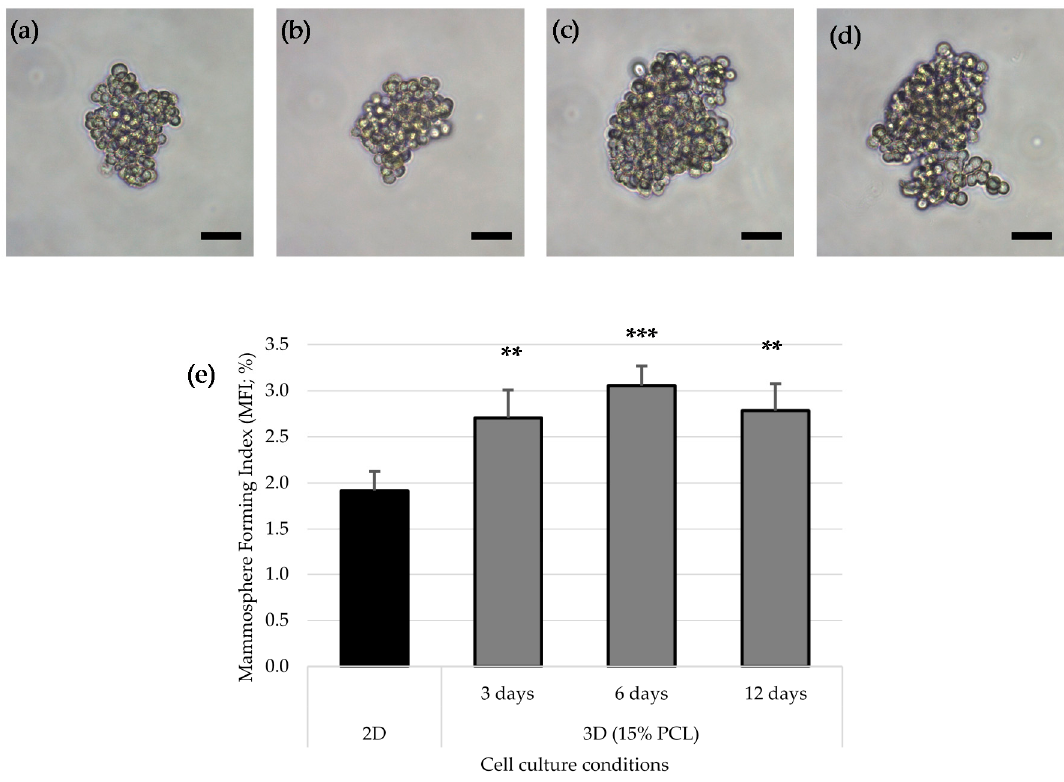
Figure 5. Mammosphere Forming Assay. Mammosphere images of MDA–MB–231 cells previously cultured on 2D surfaces ( a ) and 15% PCL scaffolds for 3 ( b ), 6 ( c ) and 12 days ( d ). (Scale bars: 50 μ m). Mammosphere Forming Index (MFI) of MDA–MB–231 cell line after 2D or 3D cell culture with 15%